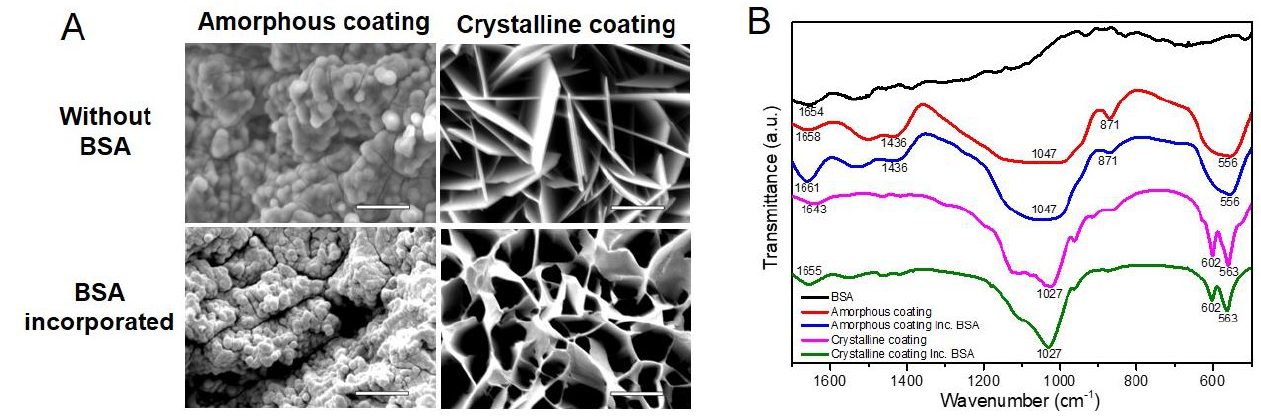
Figure 2. ( A ) Micrographs of scanning electron microscopy depicting the surface morphology of biomimetic calcium phosphate coatings deposited on mini-pin implants (scale bars = 5 μm) . ( B ) Fourier-transform infrared spectra for amorphous and crystalline coatings in the absence or pres- ence of incorporated bovine serum albumin (BSA).